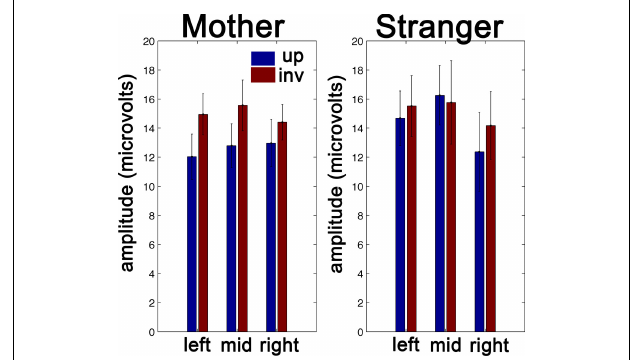
FIGURE 3 | Average P400 amplitudes by subject group and face orientation. At left, we present the between-subjects average of the P400 amplitude to the Mother’s face in upright and inverted orientations for each of our three sensor groups. At right, the same results are presented for the Stranger’s Face group. Error bars represent + / − 1 sem. calculated over the subjects in each